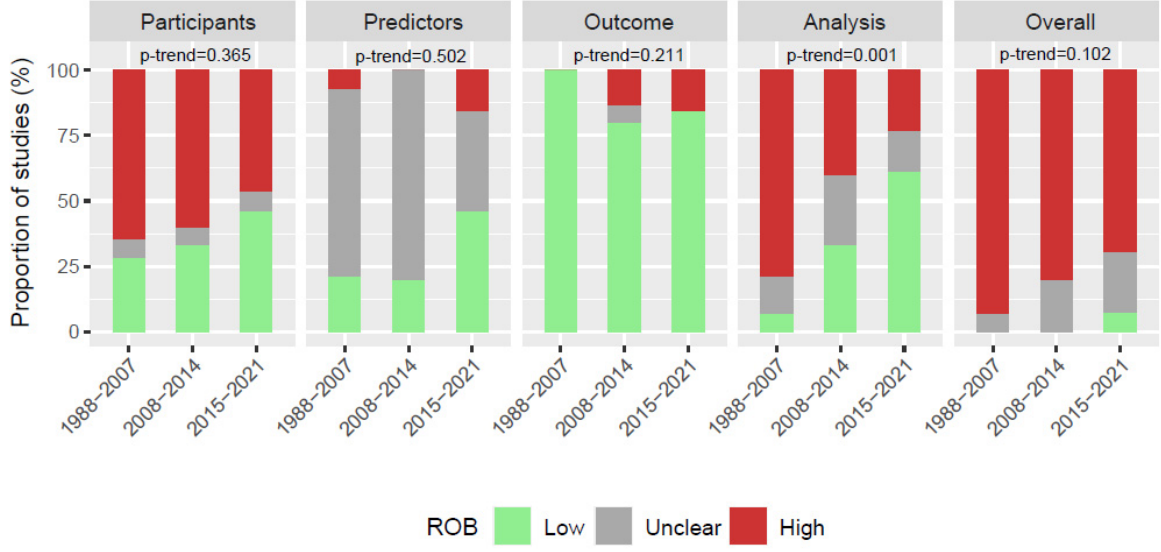
Figure 2. Comparison of proportions of studies with high, unclear, and low ROB for domain-specific and overall ratings in the three time intervals “1988–2006” ( n = 14),”2007–2014” ( n = 15) and ”2015– 2021” ( n = 13). p -values for trend were obtained using the exact Mantel